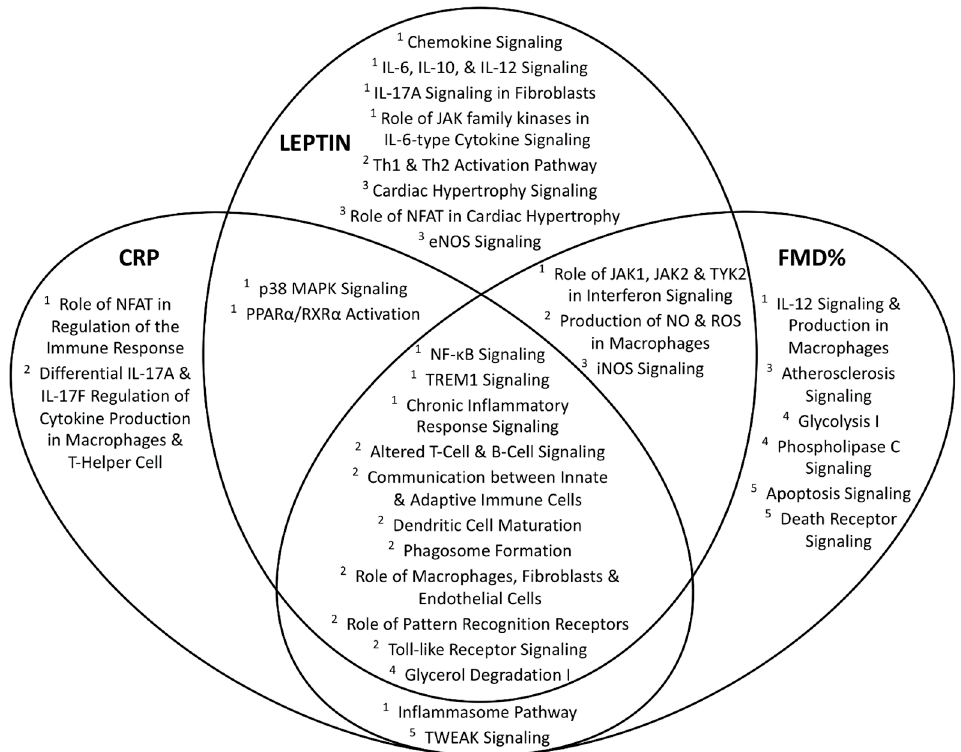
Figure 2. Overlap of significant IPA-derived canonical pathways by BMI-related cardiometabolic phenotypes. Venn-diagram depicting overlap of IPA-derived functional canonical pathways associated with each of the significant cardiometabolic phenotypes; pathway classifications are annotated as 1 inflammatory signaling, 2 immune cell function, 3 cardiovascular effect, 4 metabolic functions, and 5 cell survival/death. CRP, C-reactive protein; FMD%, brachial artery flow mediated dilation percentage; BMI, body mass index; IPA, Ingenuity Pathway Analysis